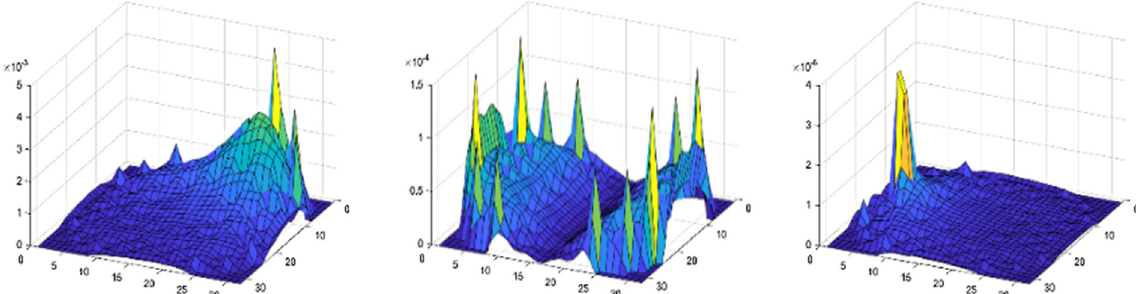
Fig. 1. Examples of the amplitude induced neutron fl ux in the frequency domain for a single azimuthal slice on the 10th axial plane. Left: Absorber of Variable Strength. Middle: Core Barrel Vibration (cid:1) Right: Vibrating Fuel